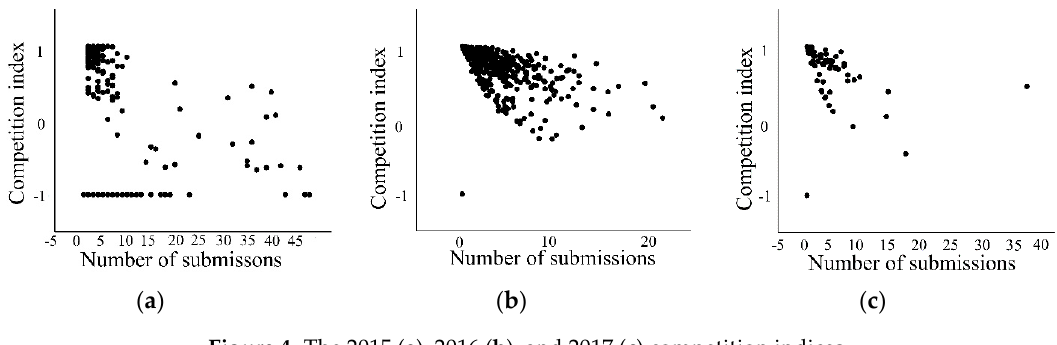
Figure 4. The 2015 ( a ), 2016 ( b ), and 2017 ( c ) competition indices.